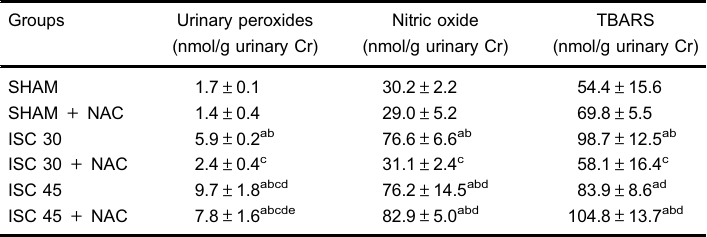
Table 3. Effect of n-acetylcysteine (NAC) treatment on reactive oxygen and nitrogen species metabolites after renal ischemia reperfusion injury. Groups